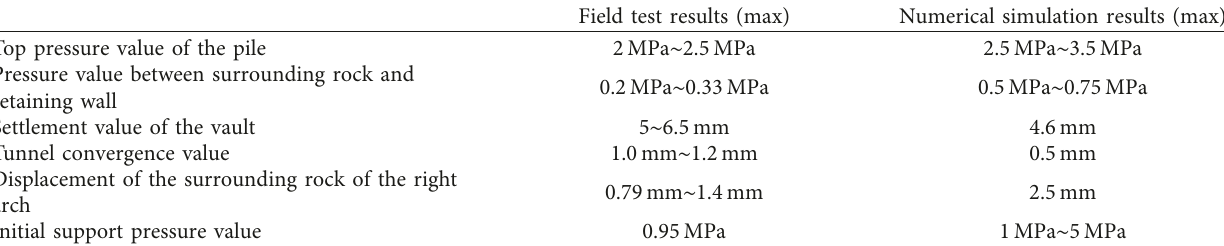
Figure 17: Displacement test of surrounding rock. (a) Internal displacement of surrounding rock of the K14 +385 section. (b) Dome settlement and peripheral convergence of the K14 +385 section. Table 2: Comparison between field test results and numerical simulation